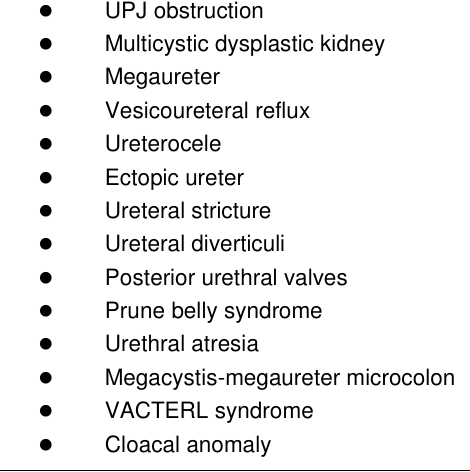
FIGURE 2 . Differential diagnosis of